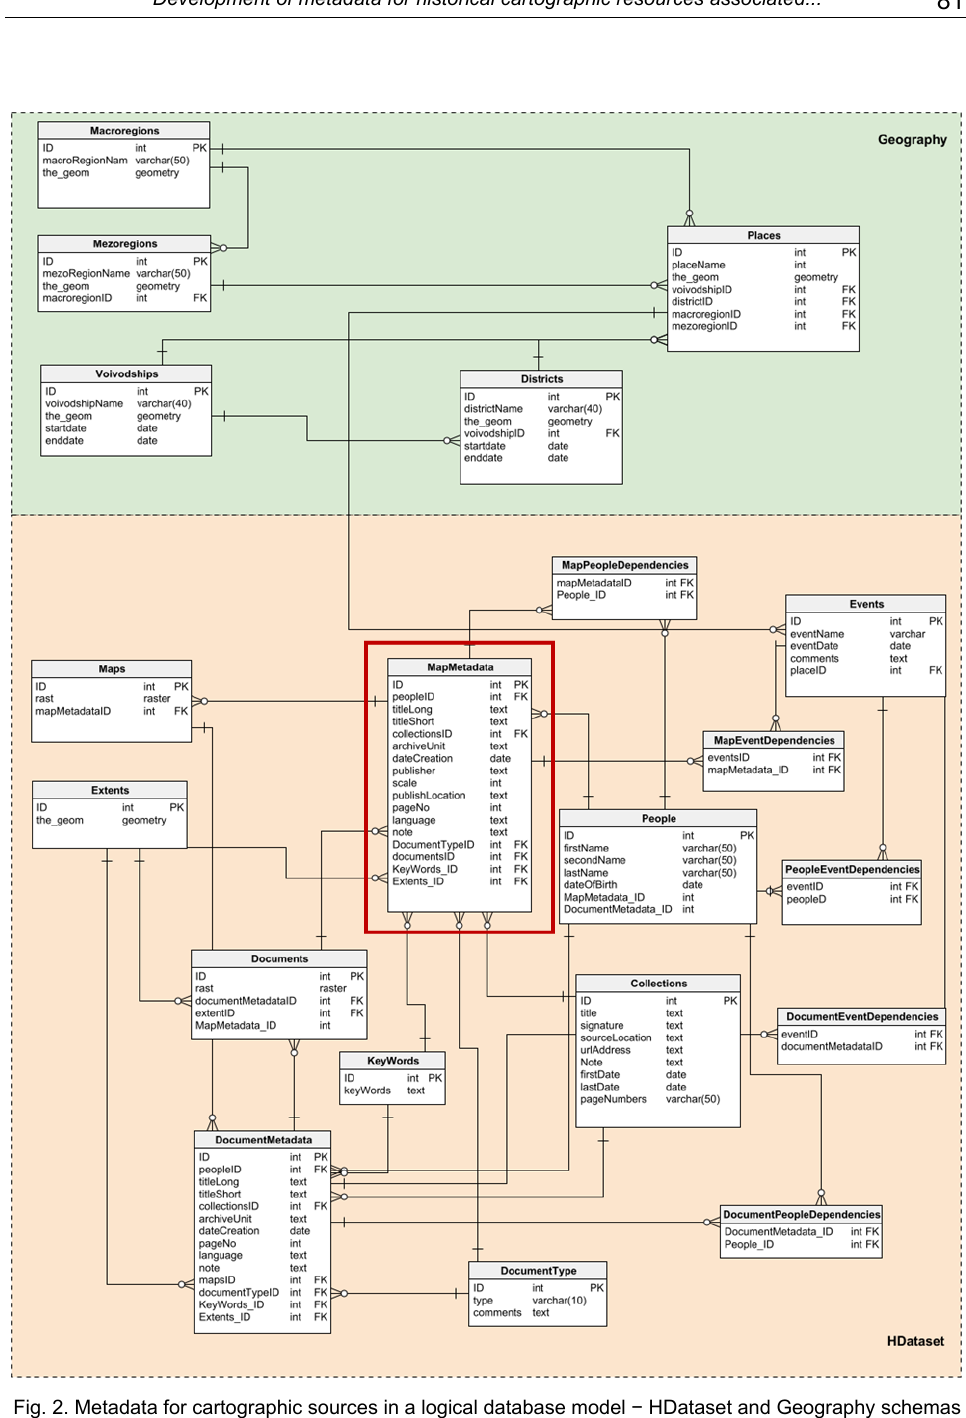
Fig. 2. Metadata for cartographic sources in a logical database model − HDataset and Geography schemas (author’s